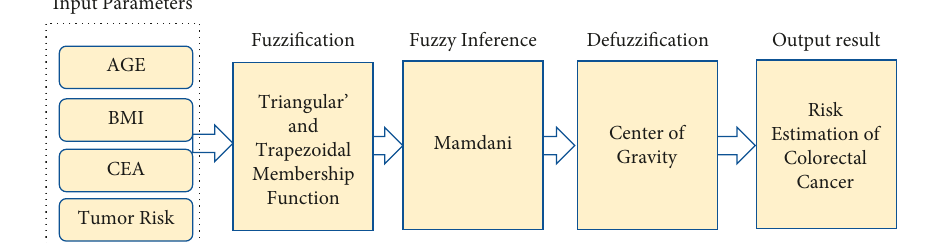
Figure 4: Schematic diagram of fuzzy evaluation.